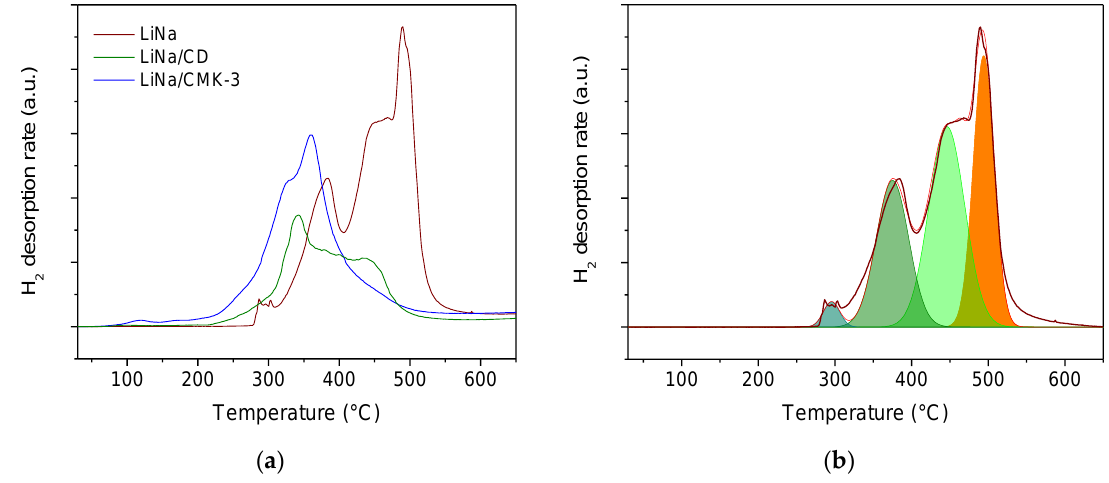
Figure 4. ( a ): Temperature programmed desorption coupled with mass spectrometry (TPD/MS, m/e = 2) results for LiNa (dark red), LiNa/CD (green), LiNa/CMK-3 (blue). ( b ): Deconvolution of the bulk LiNa TPD signal highlighting the different H 2 release reactions. The first three (green) peaks are attributed to the LiBH 4 decomposition, covering, respectively, the 2%, 26% and 39% of the total H 2 released, while the orange peak is related to the NaBH 4 decomposition (33% of the total H 2 released).